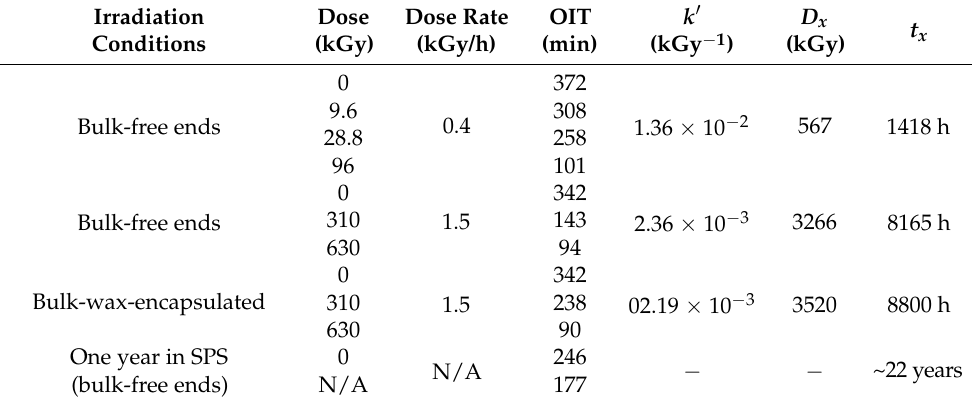
Table 3. Degradation model parameters and lifetime evaluation of EPR insulation of C2 cable (isothermal DSC measurements, T = 200 ◦ C, air; Figure S6).